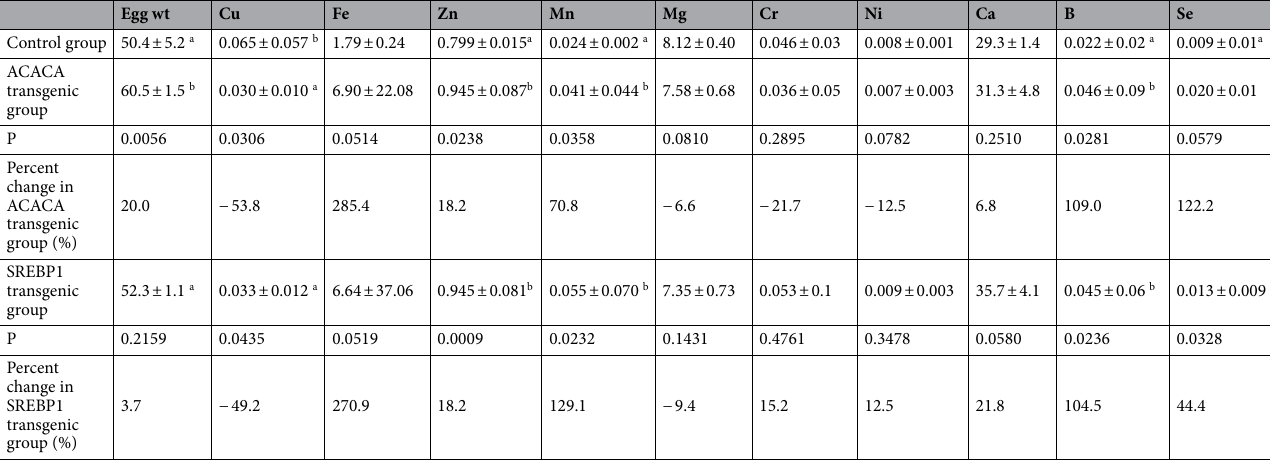
Table 10. Mineral contents (Mean ± standard deviation) in eggs of transgenic (n = 2 for ACACA transgenic group and n = 2 for SREBP1 transgenic group) and control birds (n = 2) at 52 weeks of age during 1st generation. Mineral contents viz. Cu, Fe, Zn, Mn, Mg, Cr, Ni, Ca, B and Se in eggs of both knock down and control groups were measured in iCAP7200 ICP OES Duo analyzer. Different superscripts (column-wise) indicate significant differences. The mineral contents such as Cu, Zn, Mn and B in eggs differed significantly between transgenic and control groups.